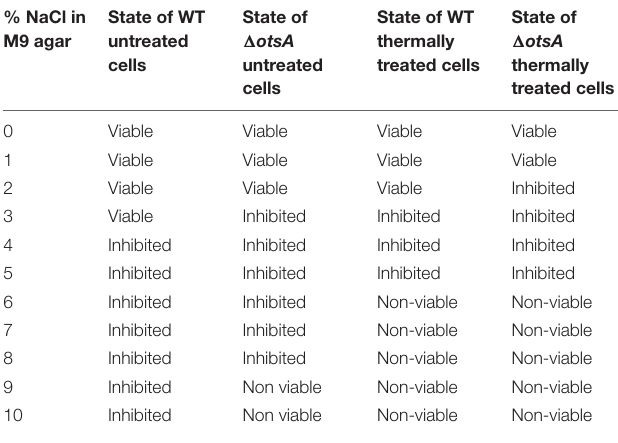
TABLE 1 | State of untreated or thermally treated cells after the incubation in M9 agar medium added with each NaCl concentration. % NaCl in State of WT M9 agar